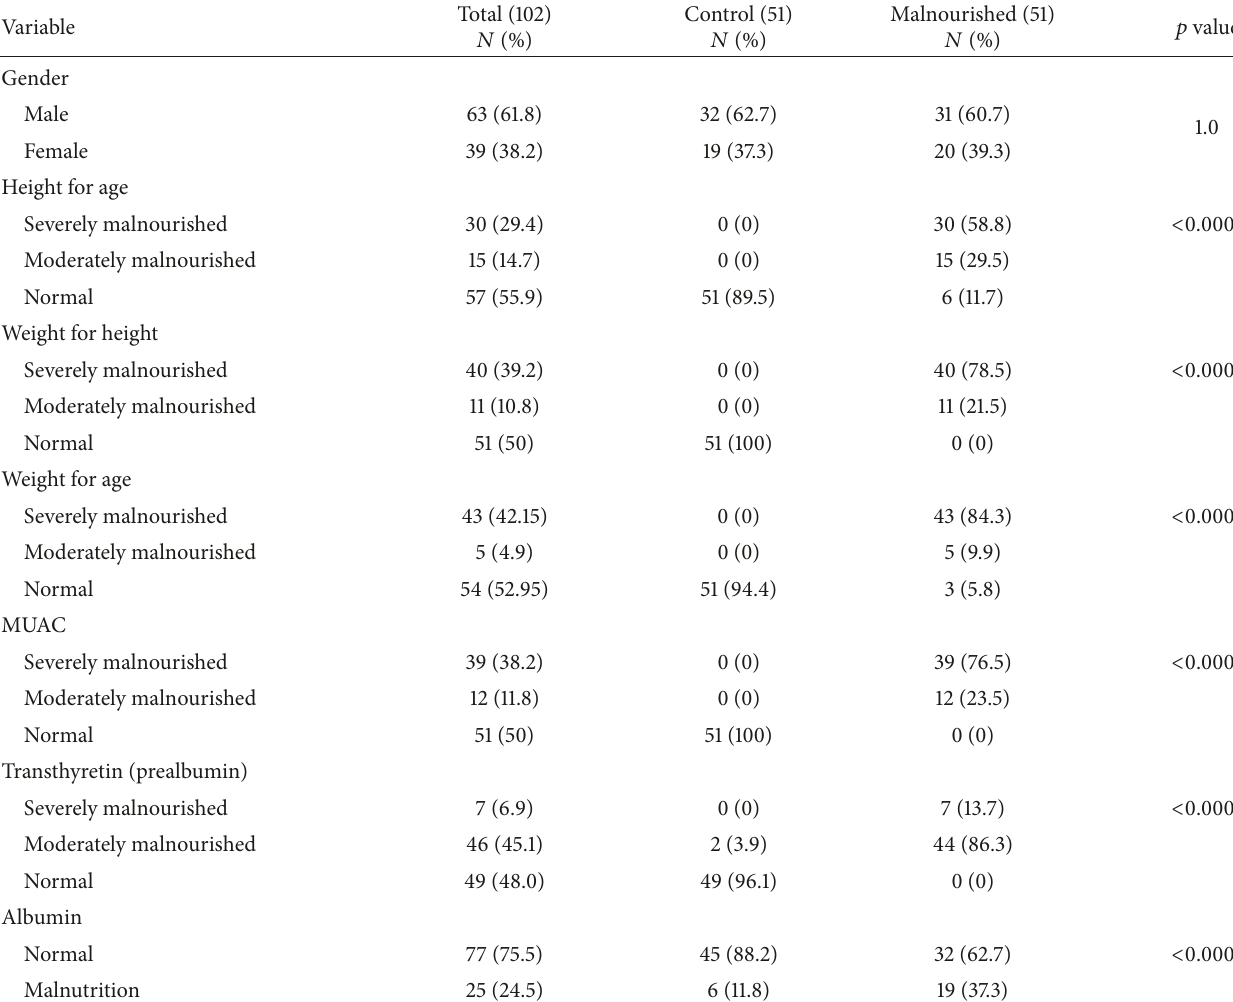
Table 2: Categorization of malnutrition between study and control groups using anthropometric and biochemical markers. Variable